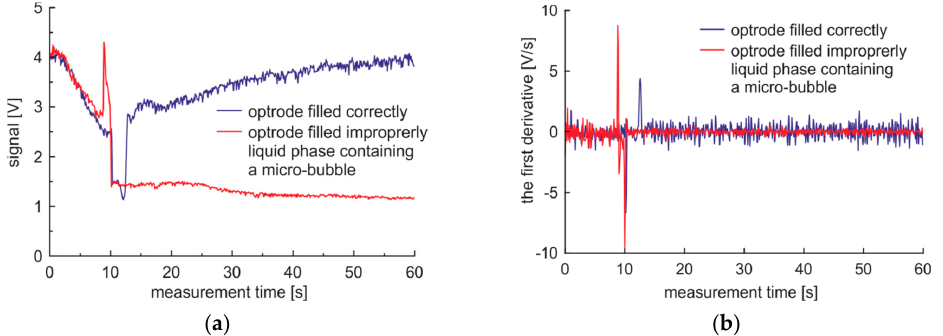
Figure 10. Measurement series of premium fuel for optrode properly filled and for optrode filled with gas phase introduced to fuel sample from cork side: ( a ) Signal; ( b ) The first derivative.